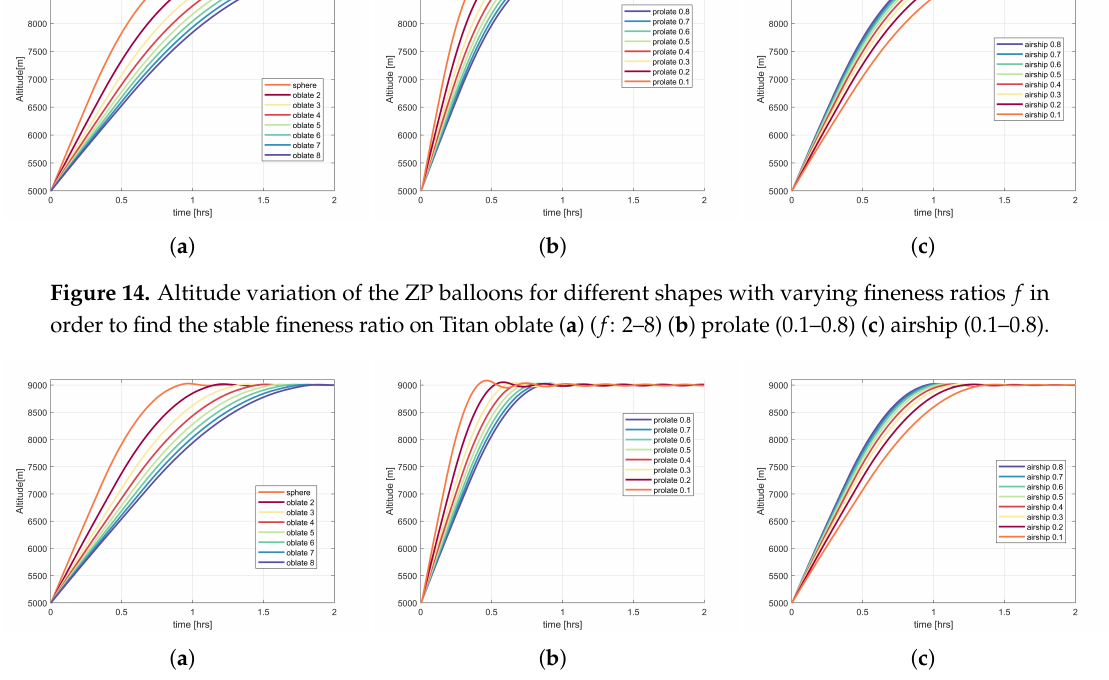
Figure 15. Altitude variation of the SP balloons for different shapes with varying fineness ratios f in order to find the stable fineness ratio on Titan ( a ) oblate ( f : 2–8) ( b ) prolate (0.1–0.8) ( c ) airship